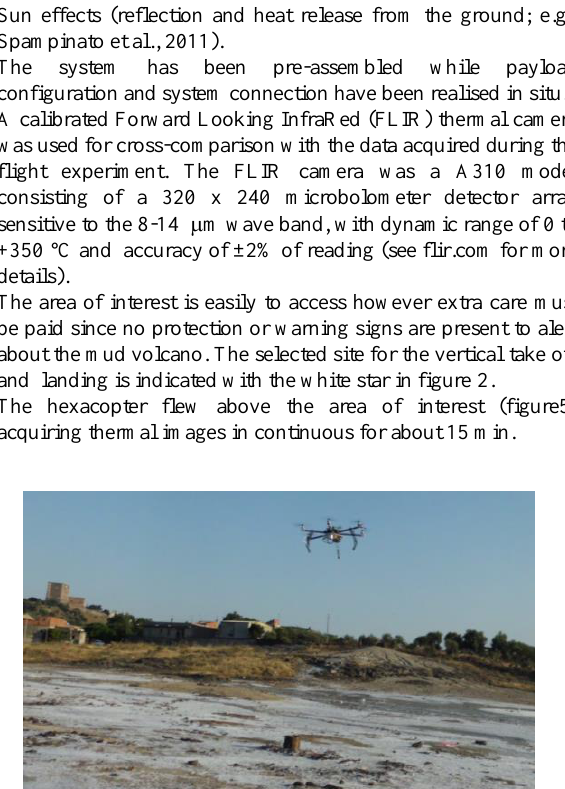
This contribution has been